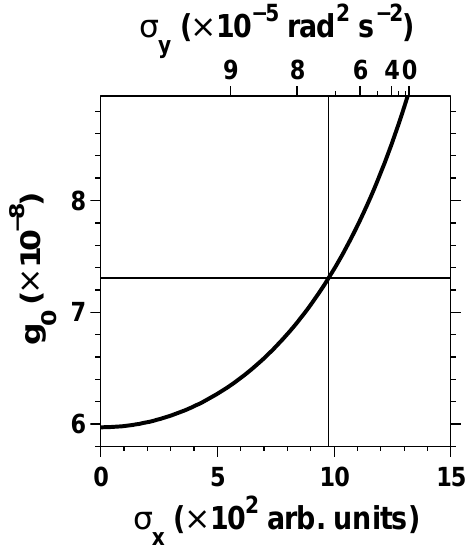
Fig. 2. The unique interrelationship between the values of σ x , σ y and g 0 following Hocking et al.